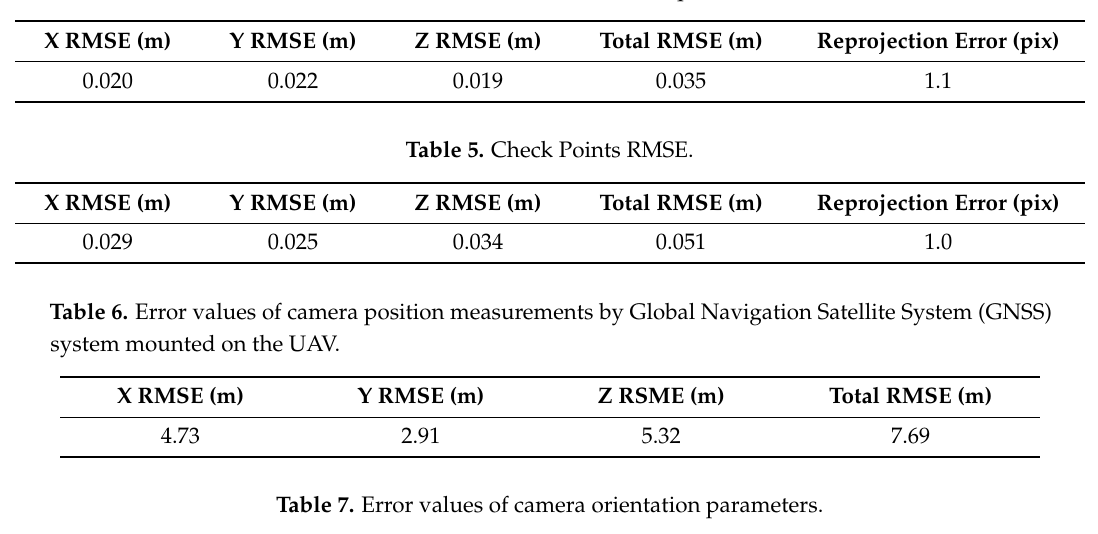
Table 4. Ground Control Points Root Mean Square Error (RMSE).